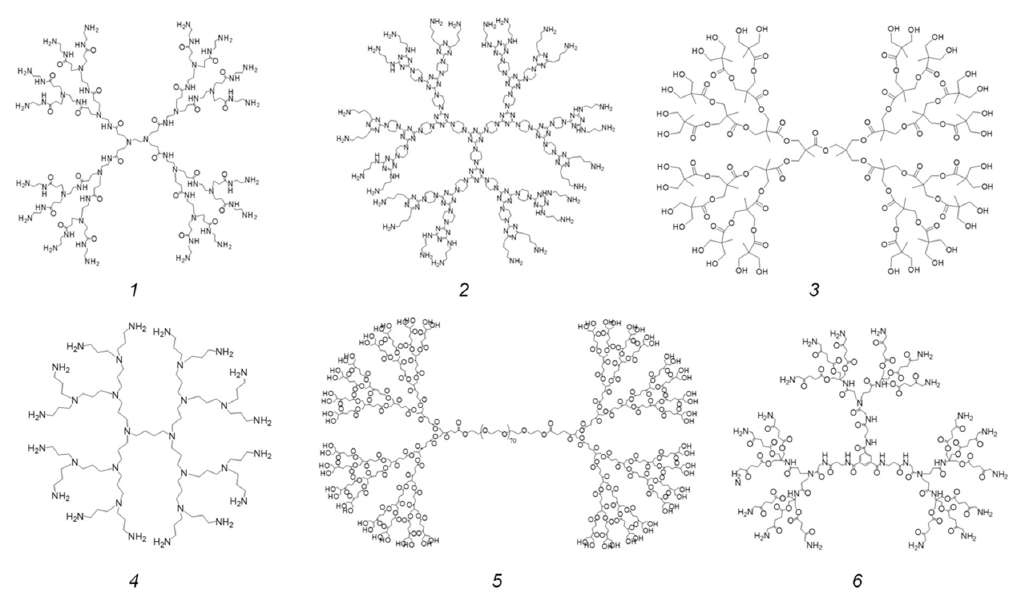
Figure 15. Structures of symmetrical branch cell dendrimer families that have been used for encapsulation of organic guest molecules or active pharmaceuticals (AP); ( 1 ) poly(amidoamine) (PAMAM), ( 2 ) triazine-based dendrimers, ( 3 ) poly(ester) dendrimers based on 2,2 ′ -bis (hydroxylmethyl) propionic acid, ( 4 ) poly (propylenimine) (PPI), ( 5 ) dendrimer based on glycerol and succinic acid with a PEG core, ( 6 ) dendrimer based on 5-amino levulunic acid. Reprinted with permission from [59]. Copyright 2008 Elsevier.